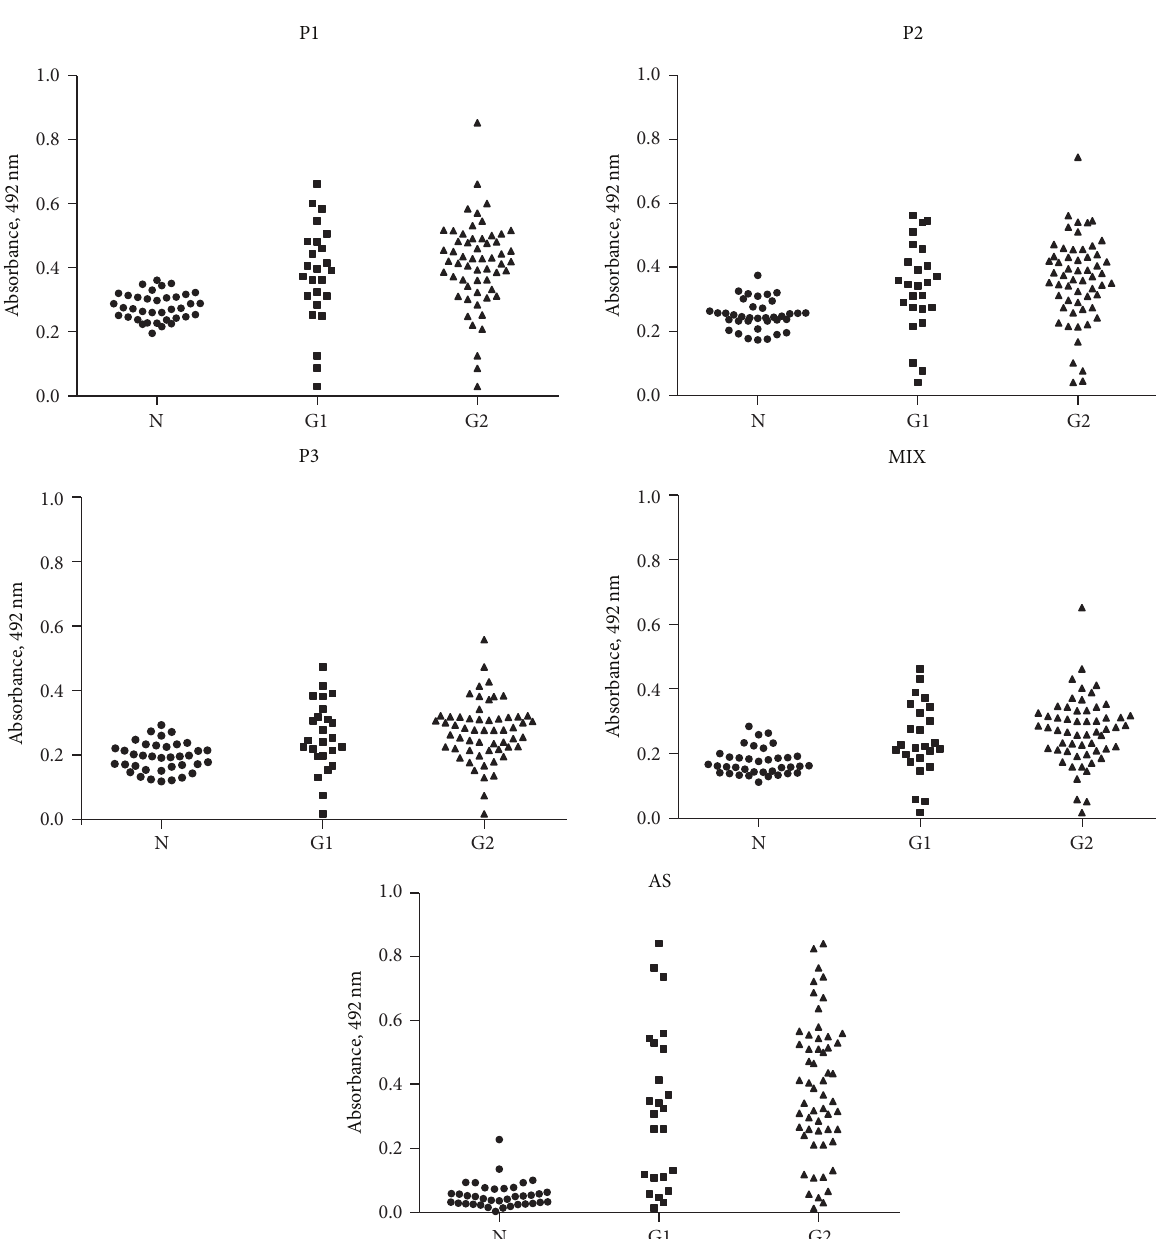
the figures stand at 100 and 100% [49], 81 and 10% [50], and 76 to 100% and 90 to 97%